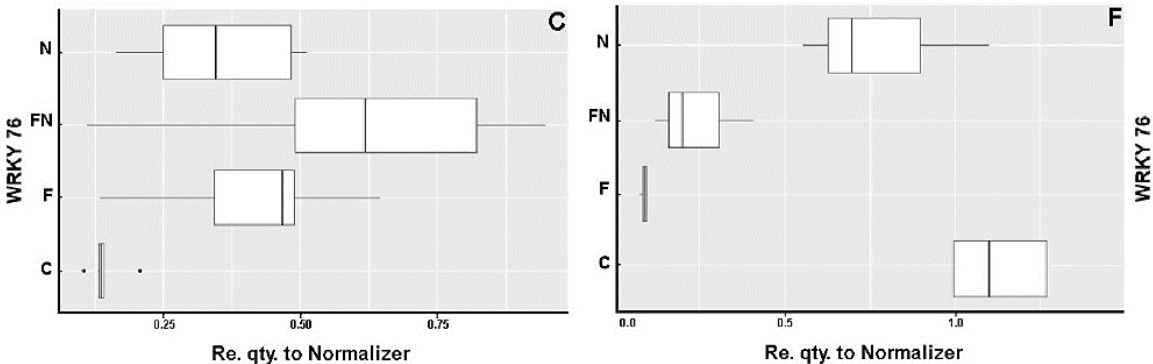
Figure 2. Expression of WRKY 25 , 44 and 76 genes in tomato accessions MRT ( A – C ) and PLZ ( D – F ). Each boxplot displays the first and third quartiles (lower and upper hinges), the median (vertical bar in the box), and the largest and smallest value (upper and lower whiskers), with outlying individual points (see Table 2 for description of treatments). Gene expression levels are shown along the x-axes as relative quantities of transcripts compared to the actin normalizer gene.